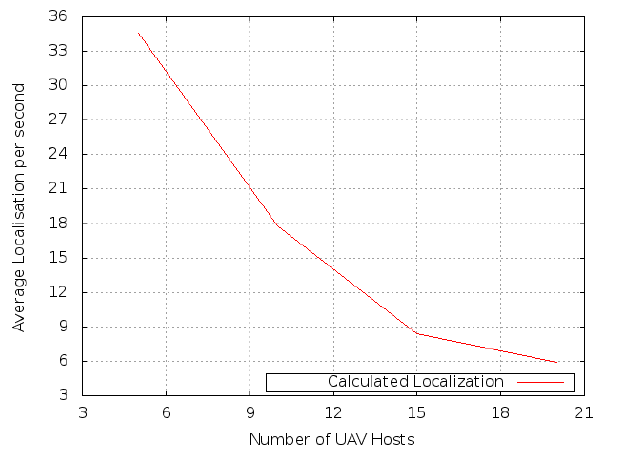
Figure 10. Localization curve without lock implemented on satellites during localization